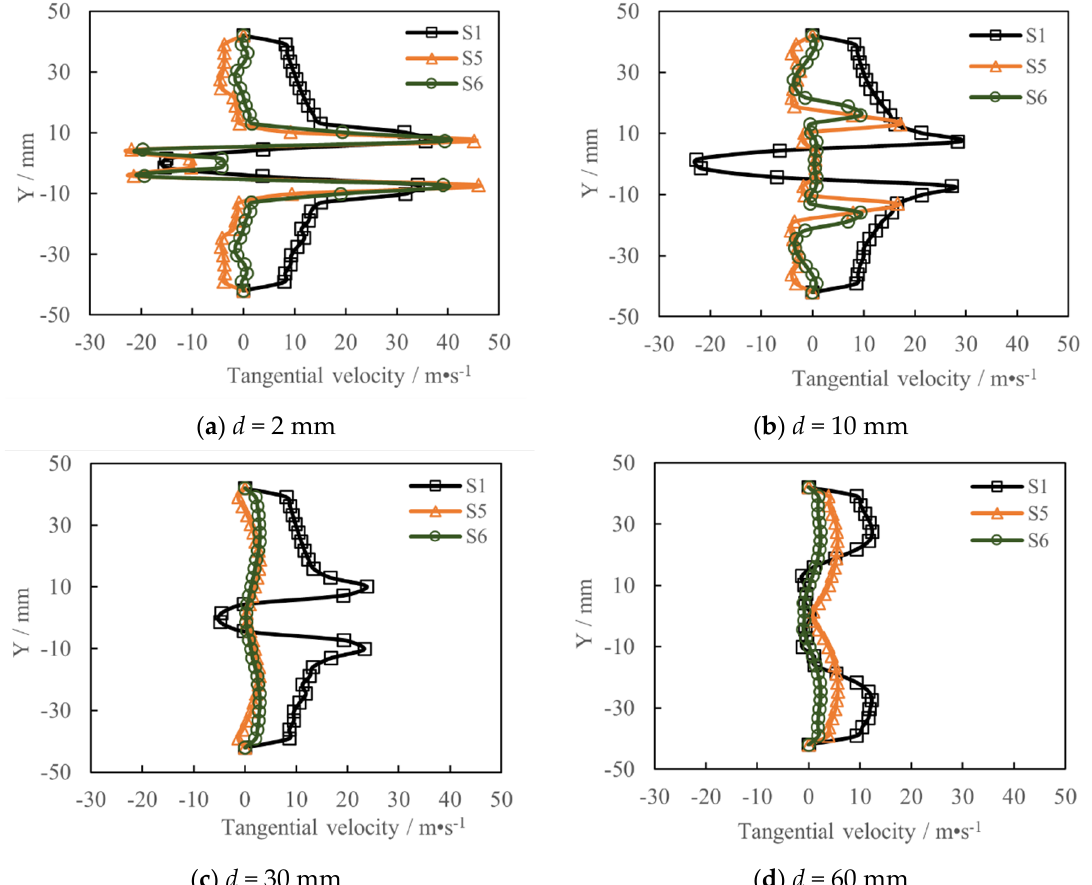
Figure 16. Radial profiles of tangential velocity.